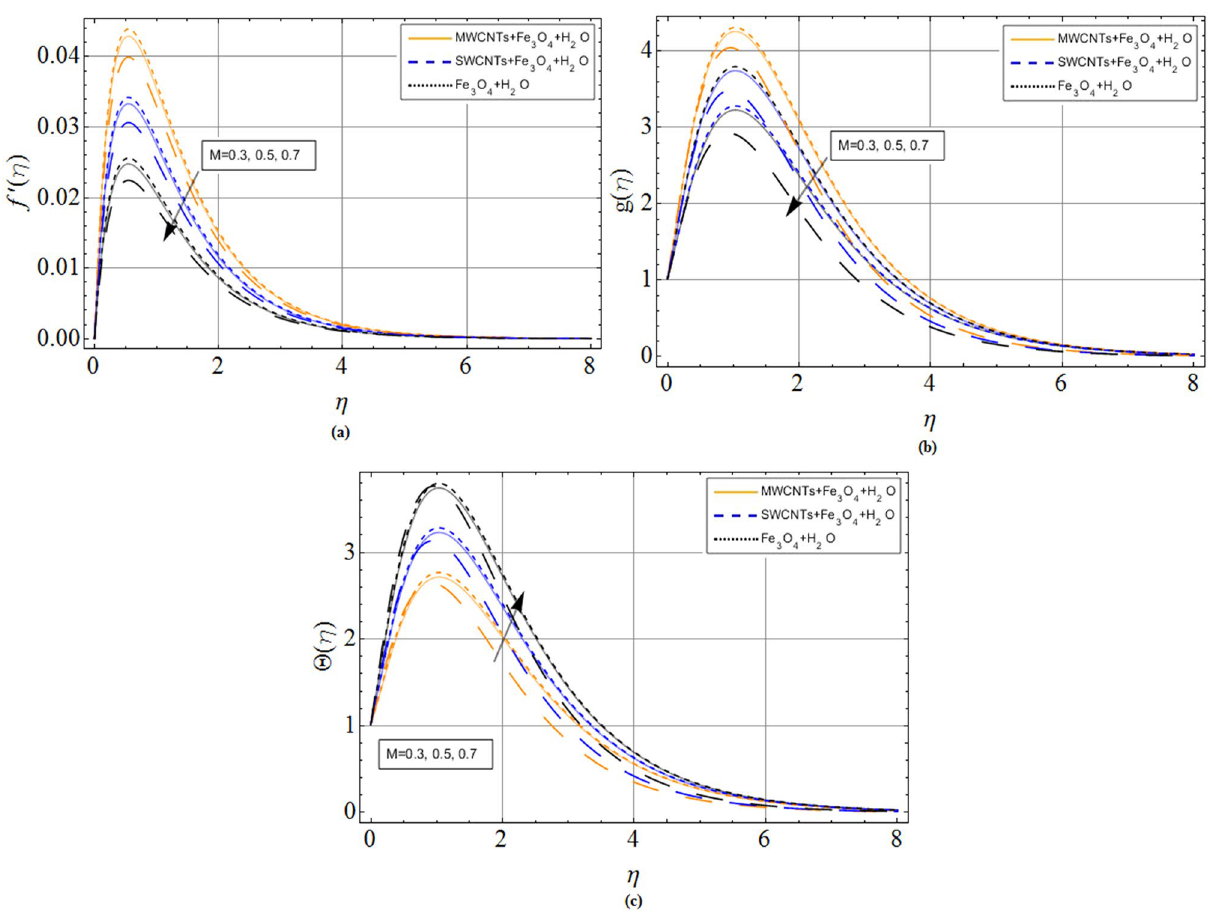
Figure 3. Magnetic parameter M effect on ( a ) axial velocity f ′ (η) ( b ) radial velocity g (η) ( c ) temperature �(η) . When φ 1 = 0.01, φ 2 = 0.2, Sc = 2.0, Pr = 6.2, M = 1.0, N =